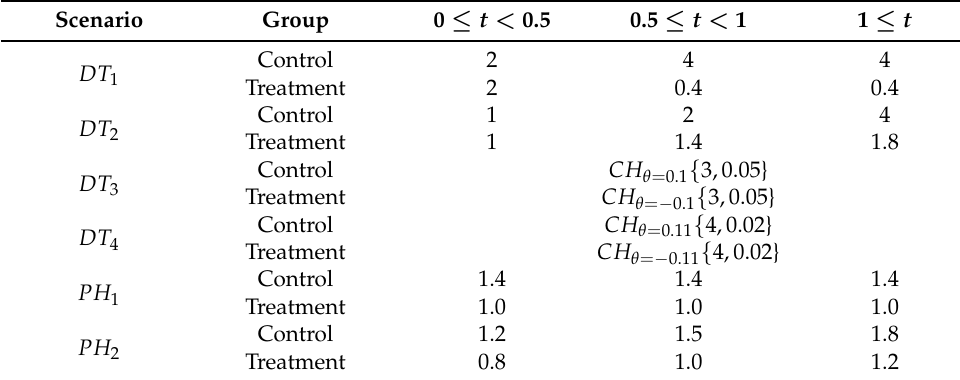
Table 3. Hazard functions of scenarios in simple settings.